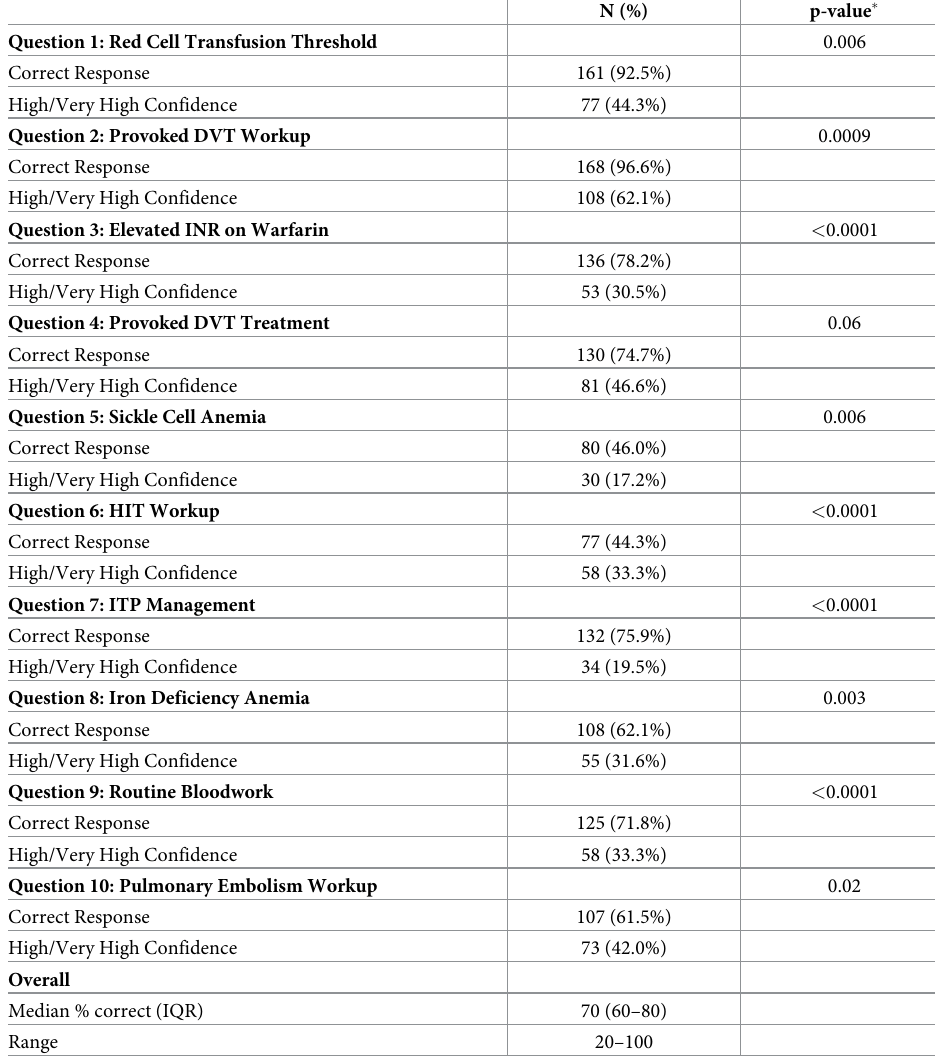
Table 2. Test results (Complete